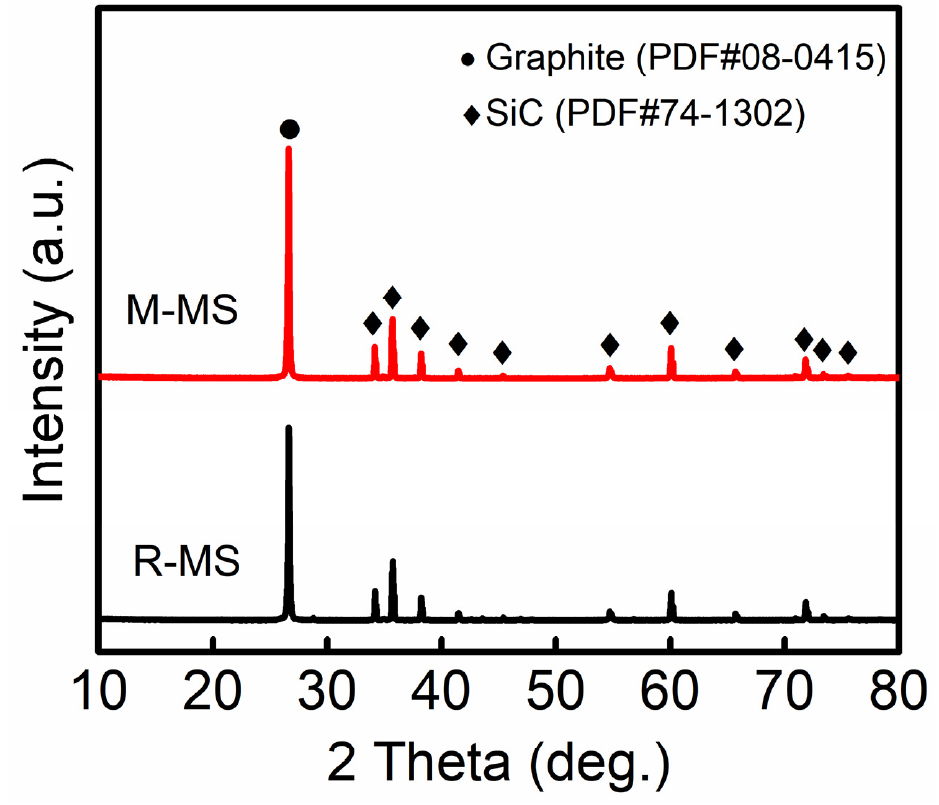
Figure 3. Phase constituents of MCMB-SiC composites.